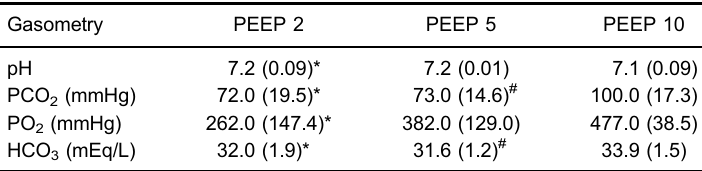
Table 1. Comparison of gasometry mean values for different fi nal positive end- expiratory pressure (PEEP) groups. Gasometry